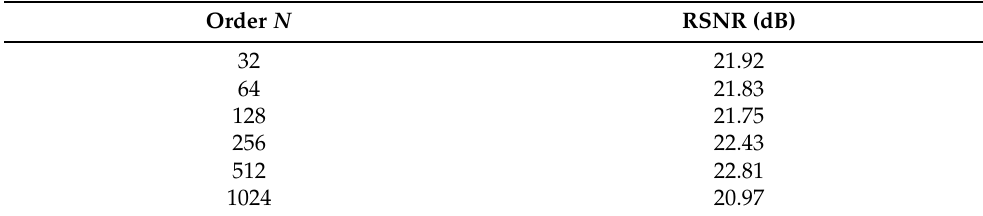
Table 2. Filter order N and RSNR ( f 0 = 1590 Hz).